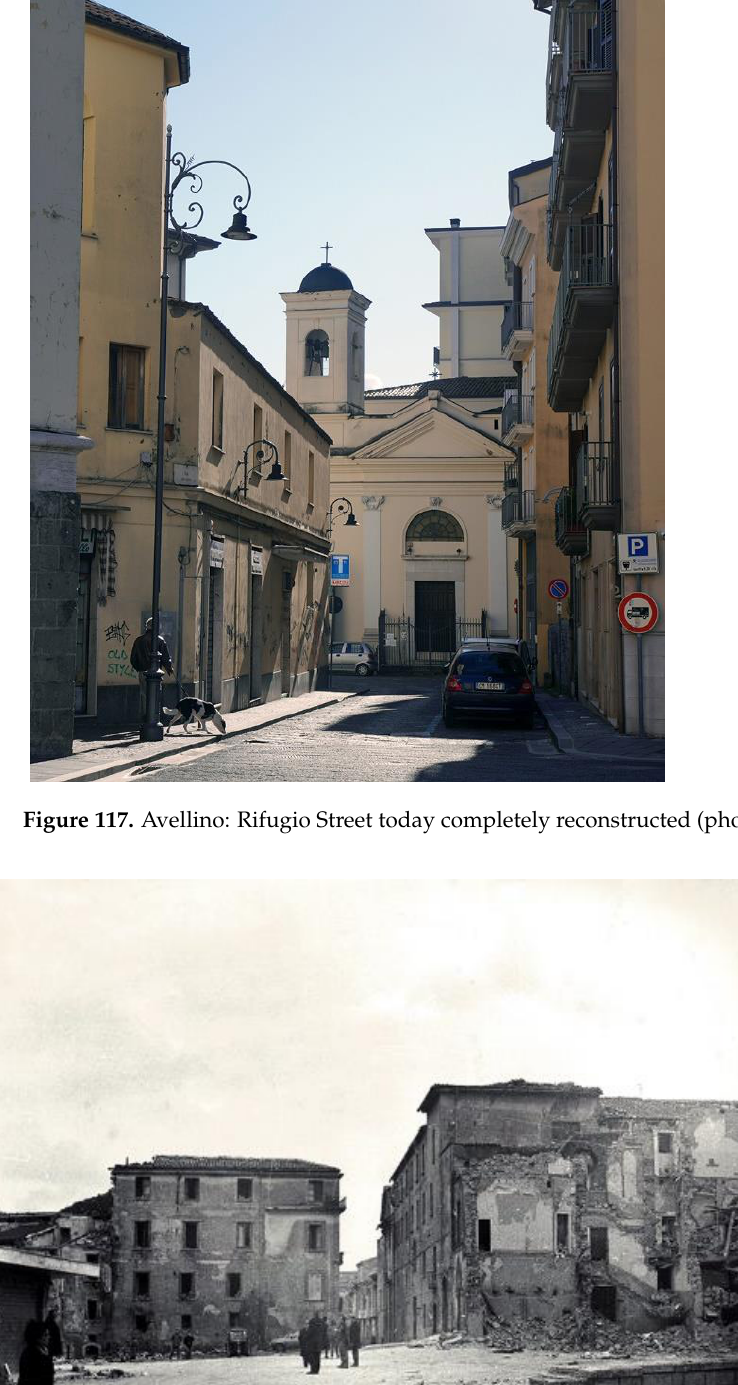
Figure 119. Avellino: “Piazza del Popolo” today completely reconstructed (photos by [35,36]). 3. Conclusions The rebuilding process, in many localities, has been driven by microzonation maps drawn up as part of the Finalized Geodynamic Project (PFG) of the National Research Council (CNR), created immediately after the 1980 earthquake [29]. The seismic microzonation maps show the areas with different seismic characteris- tics, illustrating the morphological structure of the territory, the distribution of the build- ing heritage existing in 1980, and in some cases, the level of damage suffered due the 1980